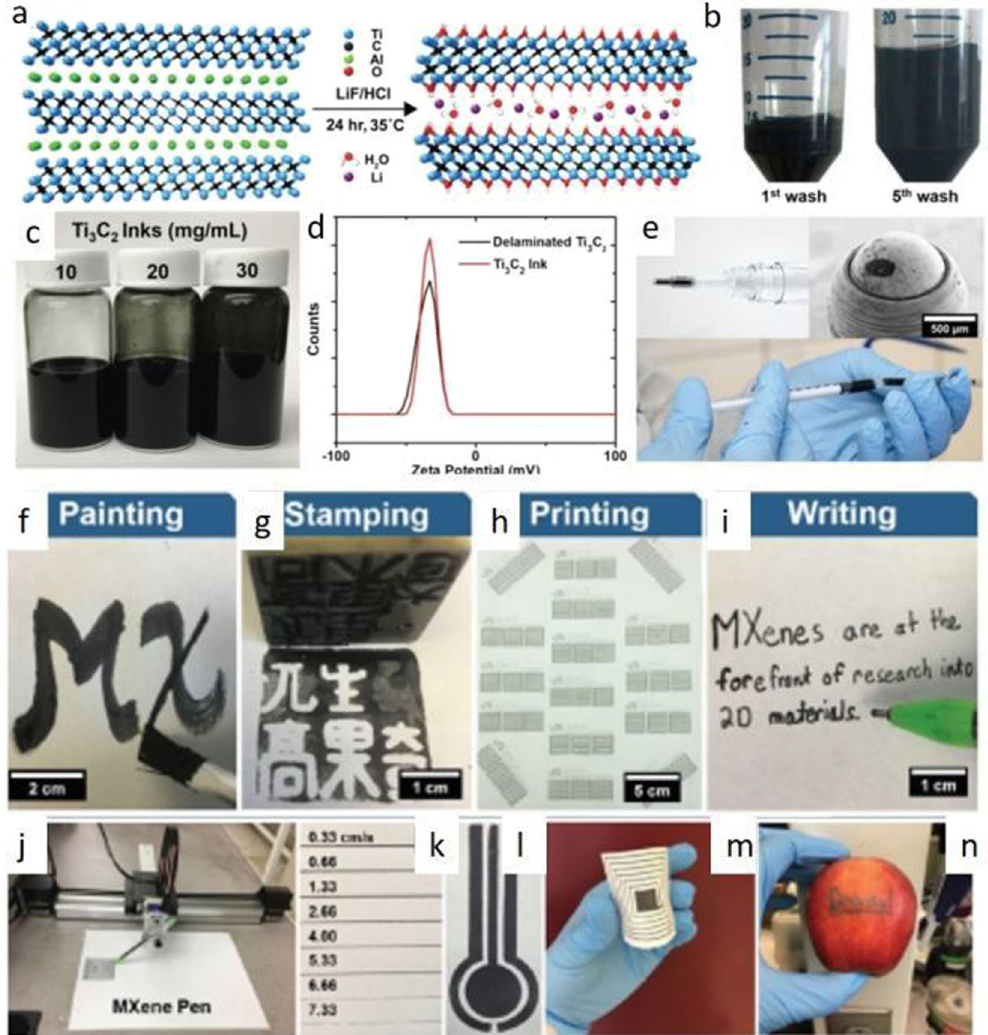
Fig. 3 Additive-free water-based MXene ink preparation. a schematic illustration of the MILD etching method using LiF/HCl at 35 °C for 24 h, b Ti 3 C 2 sediment swelling during washing step, c different concentrations of MXene inks in glass vials, and d Zeta potential of the Ti 3 C 2 Mxene, e optical images of rollerball pen images for direct writing of Ti 3 C 2 inks., Water-based MXene inks for prototype fabrication: f painting, g stamping, h printing, and i writing of Ti 3 C 2 on a paper substrate, respectively. j MXene has written on different substrates, k drawing apparatus (AxiDraw) with automatic set-up and patterning controlled with a computer, l Ti 3 C 2 ink lines fabricated at different speeds pen writing, m versatile MXene ink patterning with AxiDraw, and n demonstration showing MXene inks portraying patterns onto even fruit surface. Reprinted with permission from 64 .